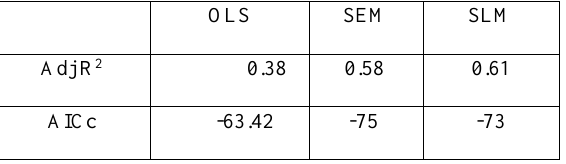
Table 3. Comparison of the global regression